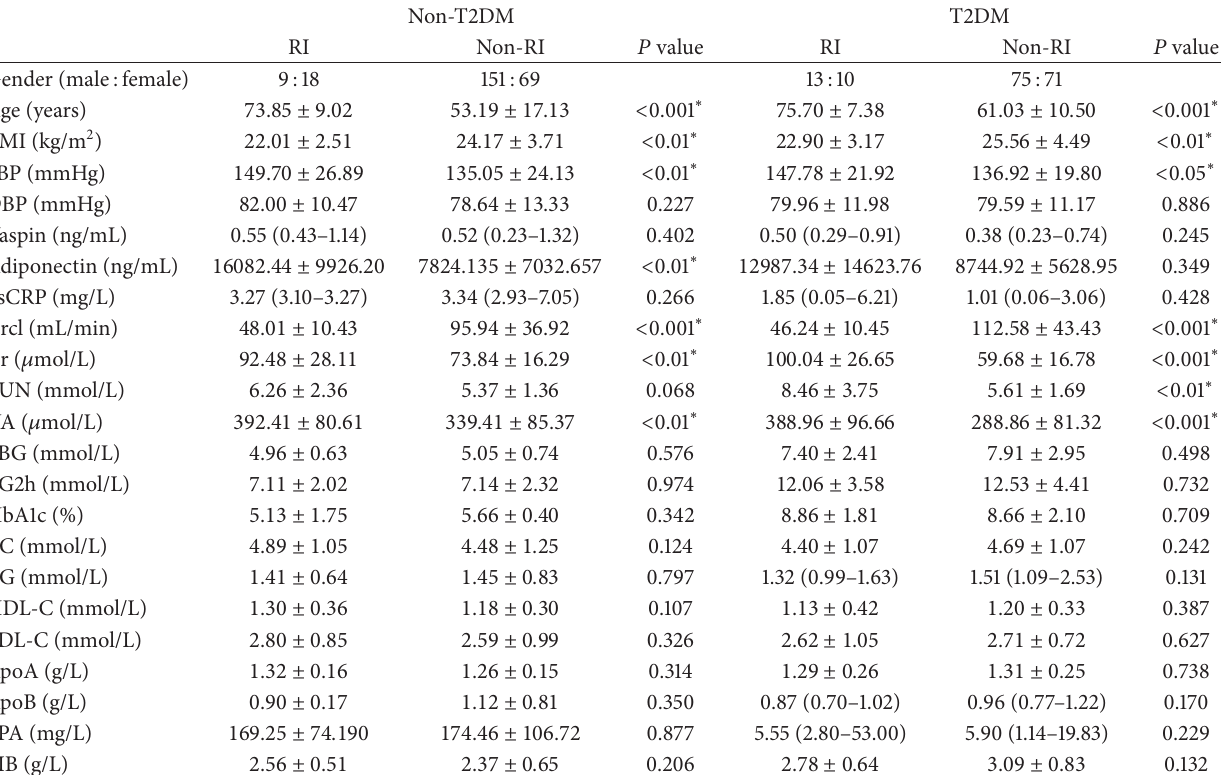
Table 1: Baseline of all subjects divided by T2DM and